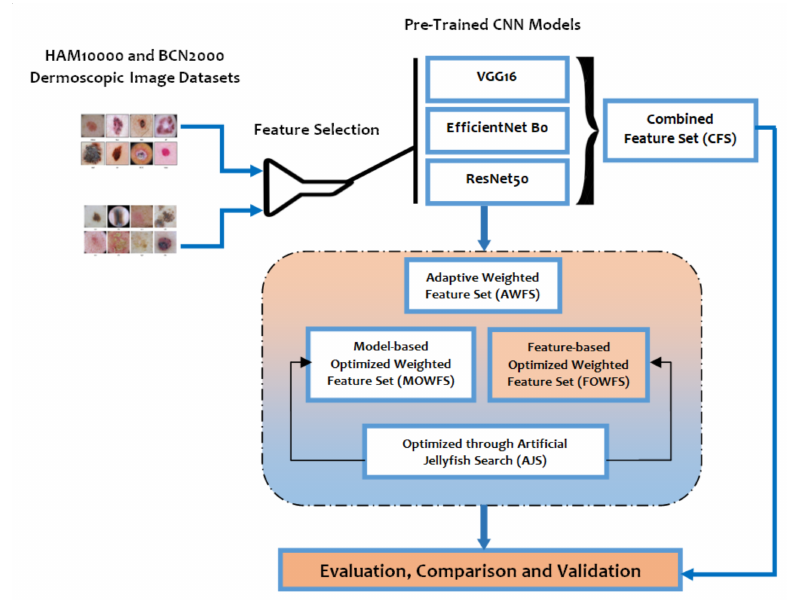
Figure 3. Layout of proposed feature fusion approach for skin lesion data